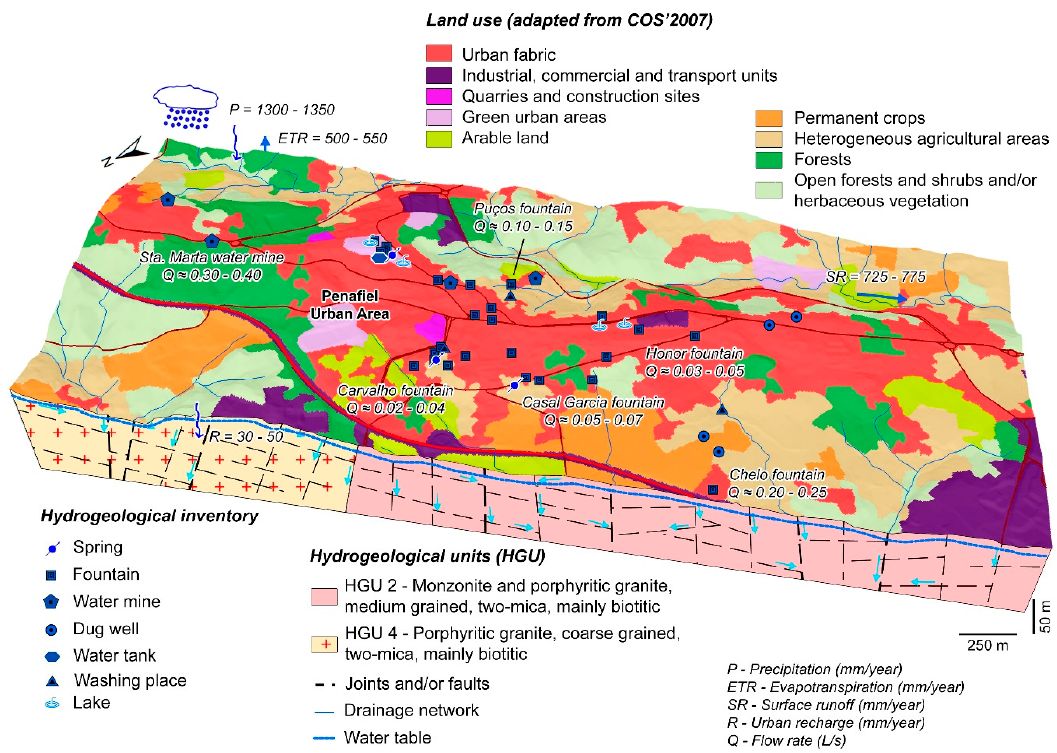
Figure 12. Urban hydrogeological conceptual site model in the Penafiel urban area (NW Portugal).